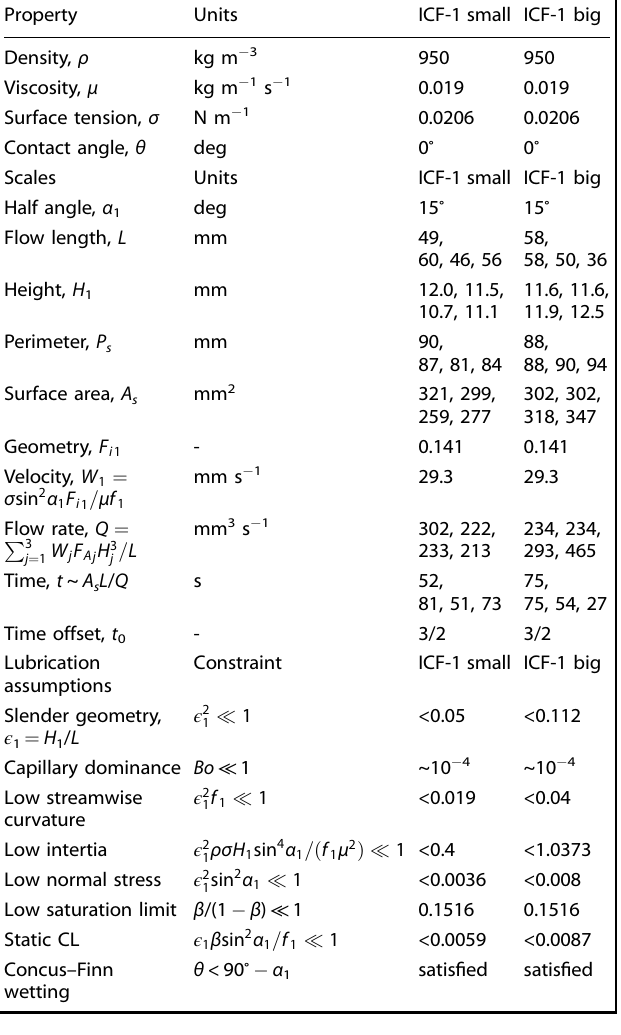
Table 1. ICF-1 fl uid properties, scales, and constraints. Subscript 1 denotes the primary α 1 = 30 ∘